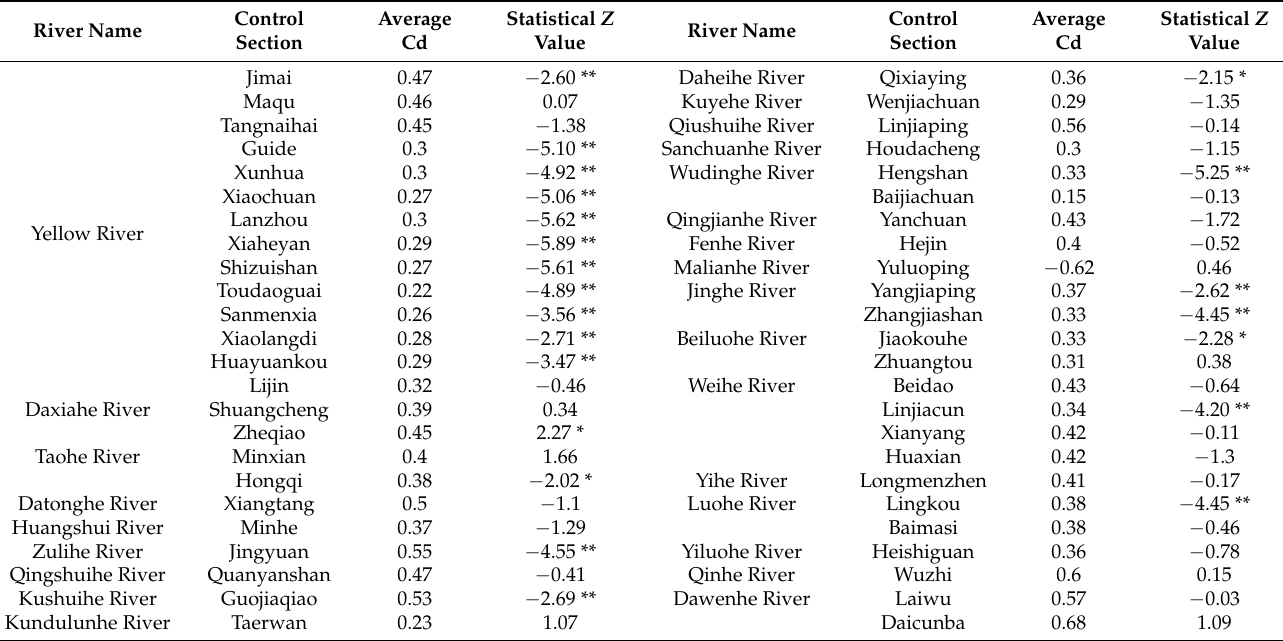
Figure 3. Interannual variation trend of runoff in dry season at main control sections of the Yellow River Basin. Table 4. Annual concentration variation trend of runoff at main control sections in the Yellow River